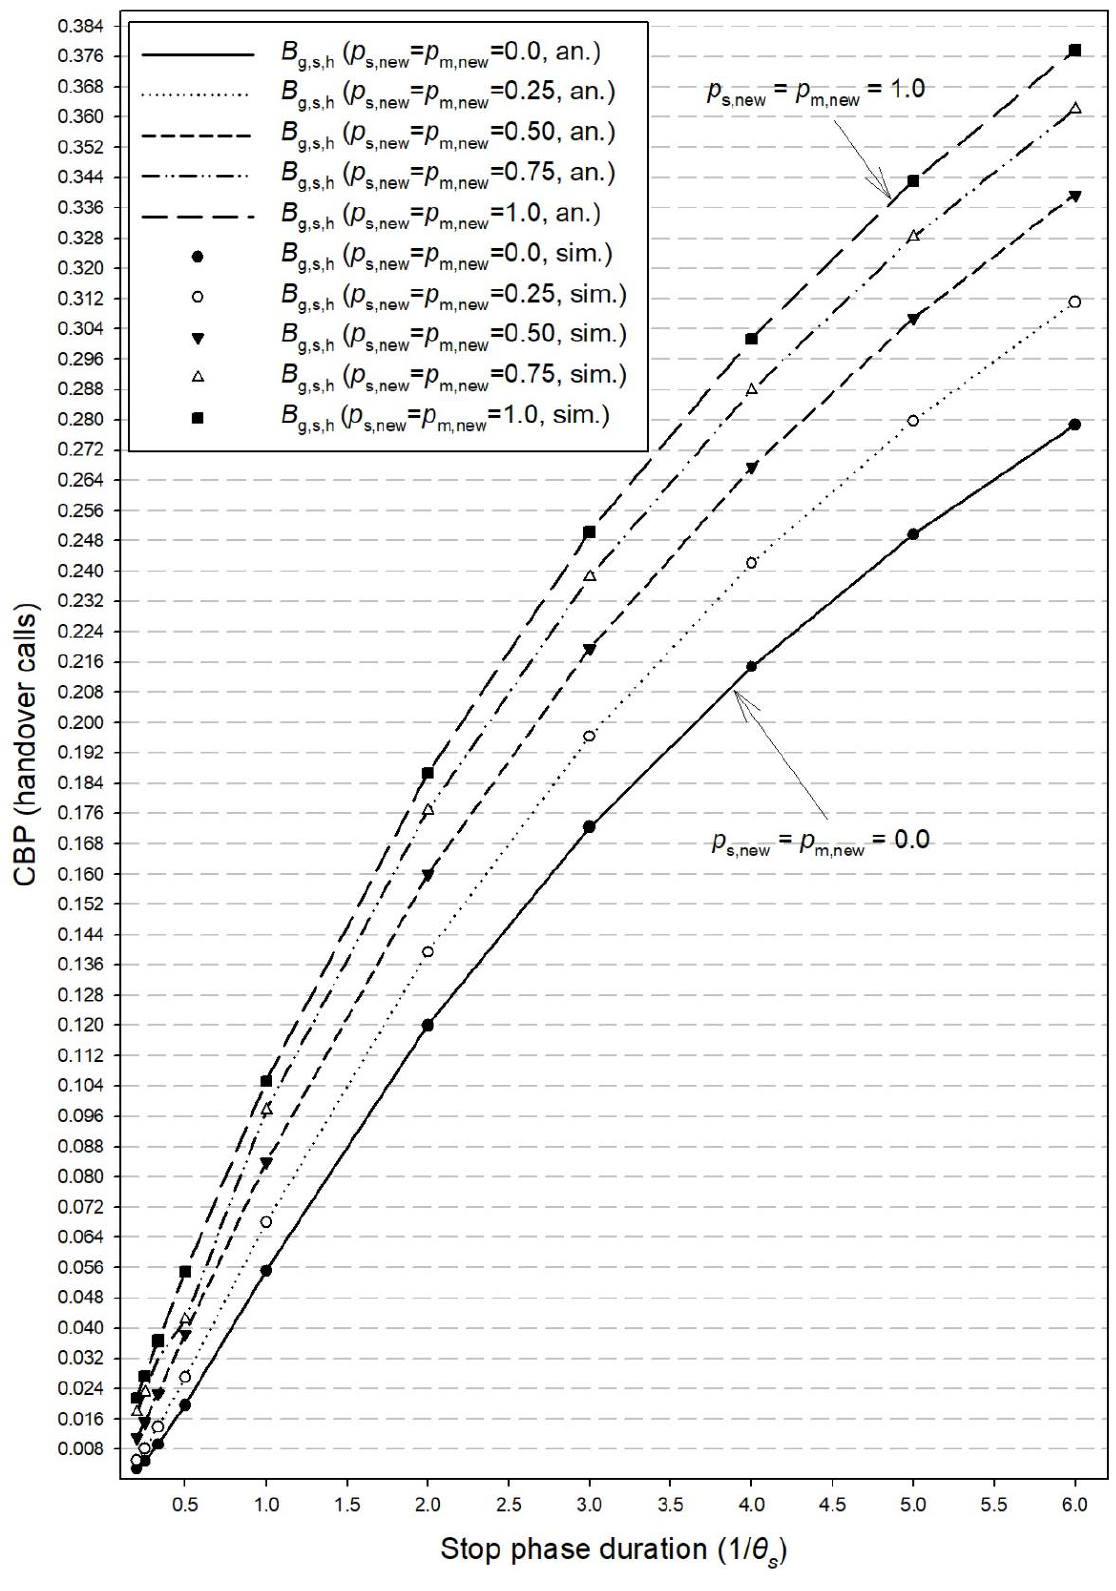
Figure 7. CBP of handover calls (in the stop phase) for different values of θ − 1 s